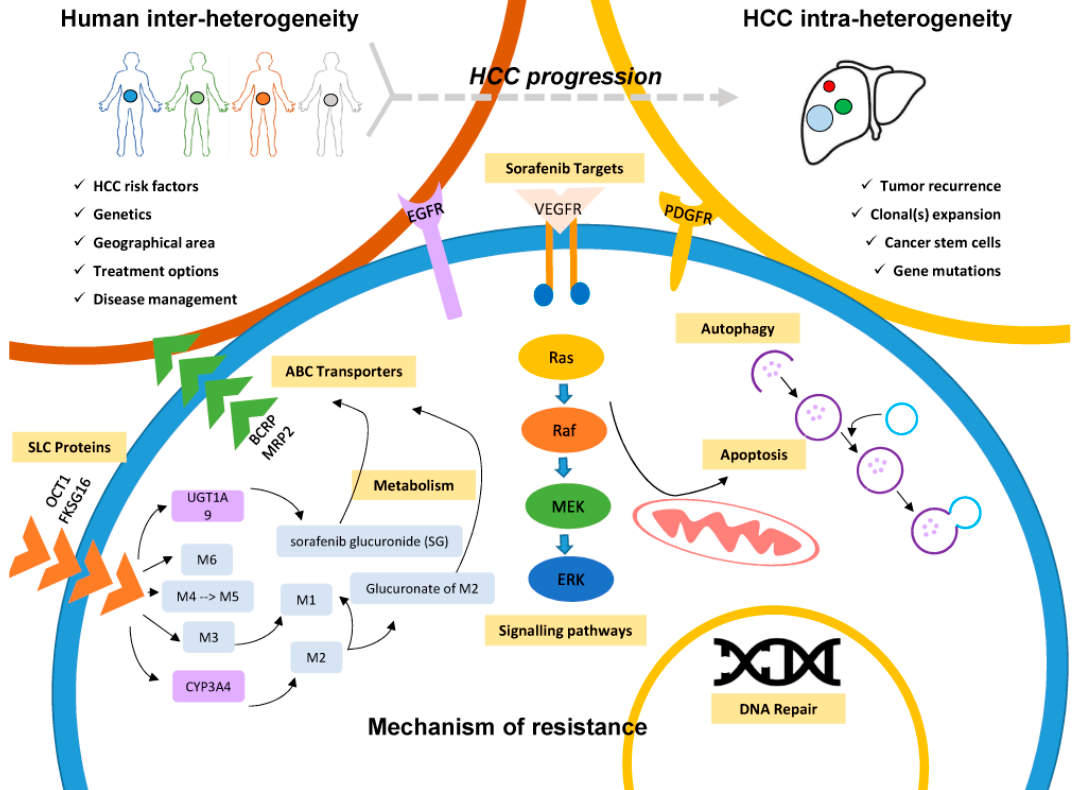
Figure 2. Mechanisms of sorafenib resistance. Sorafenib as an anticancer drug is transported into the cell through SLC proteins (e.g., OCT1). Inside the cell, the drug is broken-down via phase 1 cytochrome P450 3A4 (CYP3A4) and phase 2 UDP glucuronosyltransferase 1A9 (UGT1A9) mediated metabolism to form the M1-M8 metabolites [84]. Sorafenib glucuronide (SG) is excreted out of the cell by a process mediated by ABC transporters. Aberrations in the expression of SLC proteins and ABC transporters, as well as genetic polymorphisms in metabolizing enzymes can control intracellular concentration, subsequently influencing drug e ffi cacy. Sorafenib is a drug designed to target multiple tyrosine kinase inhibitors such as VEGF, PDGF, and EGF that activate downstream signaling pathways such as the Ras / Raf / MEK / ERK pathway. Overexpressed drug targets and perpetually activated signaling pathways will promote cell proliferation and survival, therefore promoting chemoresistance. Cellular processes such as DNA repair, apoptosis, and autophagy can redirect their e ff ect to promote cell proliferation and survival rather than cell